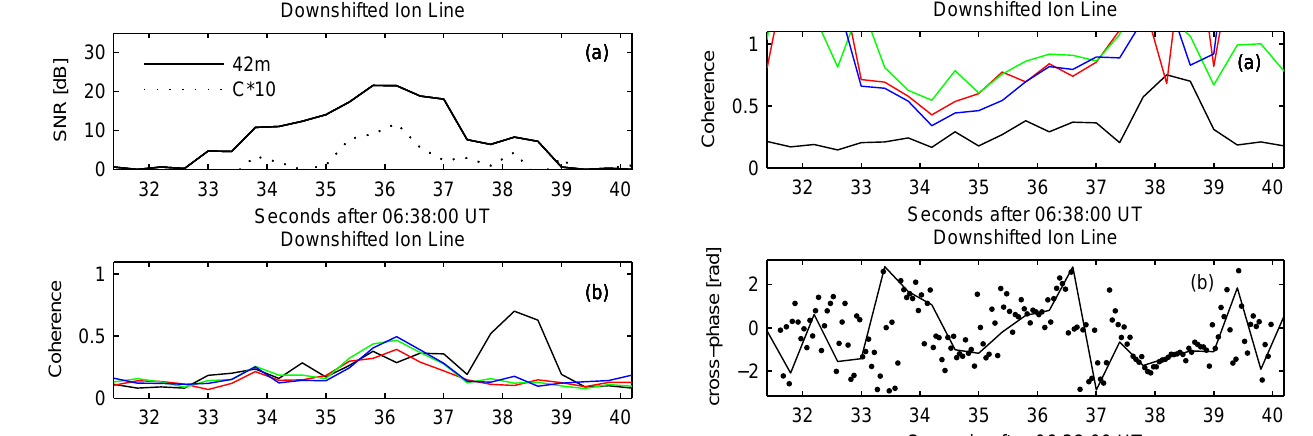
Figure 4. Time history of received power and coherence at 400km range with 45km range and 400ms time integration. Panel (a) shows the SNR of the down-shifted ion line observed with the re- ceivers 42m and C. For better visibility of the curve the SNR of receiver C was multiplied by a factor of 10dB. Panel (b) shows the coherence of the down-shifted ion line as observed with the 42– 32m receiver pair (black) and all three combinations of receivers A, B, and C where the color annotation is the same as in Fig. 1.